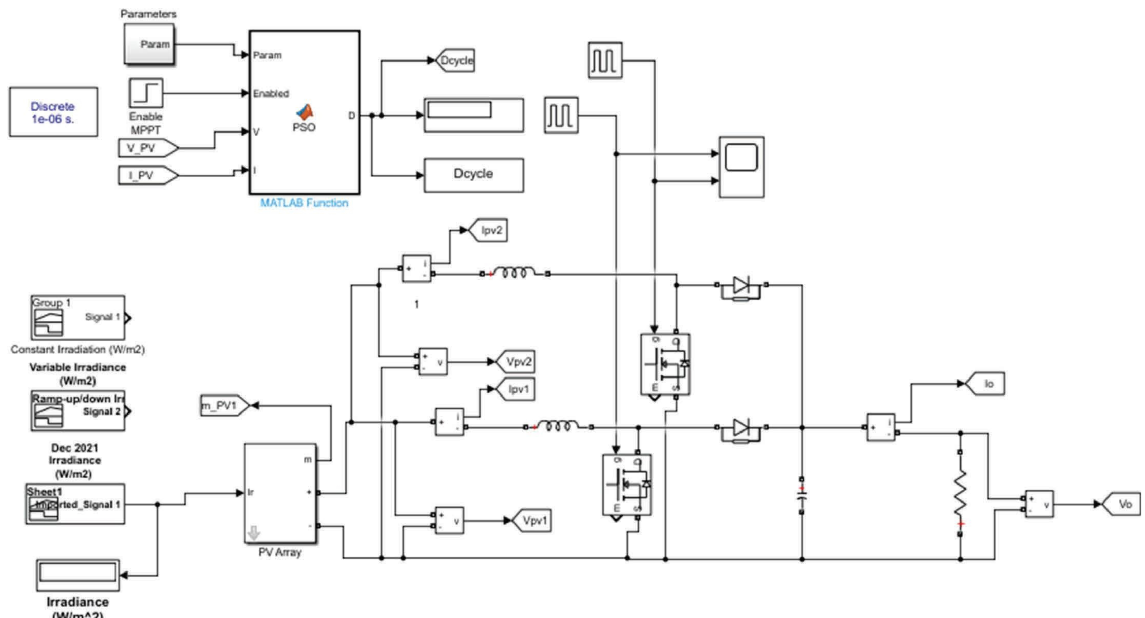
Figure 10: Simulink model of the system.